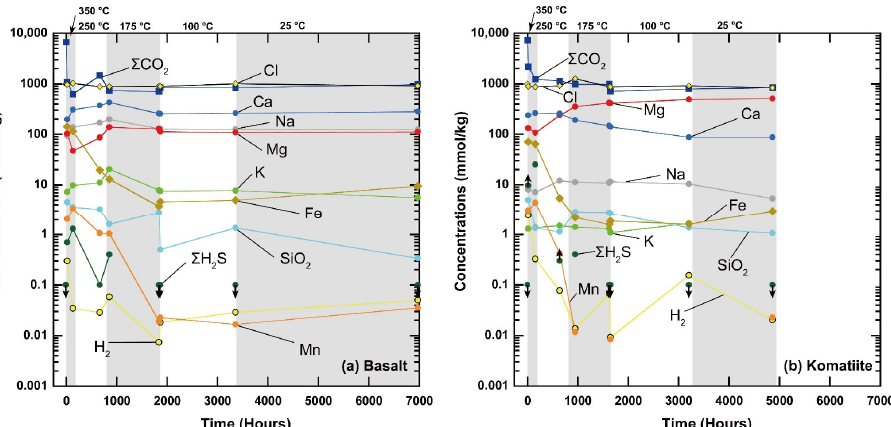
Figure 3. Concentrations of the dissolved species in aqueous fluid in ( a ) Exp-B and ( b ) Exp-K. The background colors represent each temperature during the experiments at 350, 250, 175, 100, and 25 °C. The green circles with black arrows mean that ΣH 2 S concentrations in the plot are the maximum and minimum estimates, respectively.